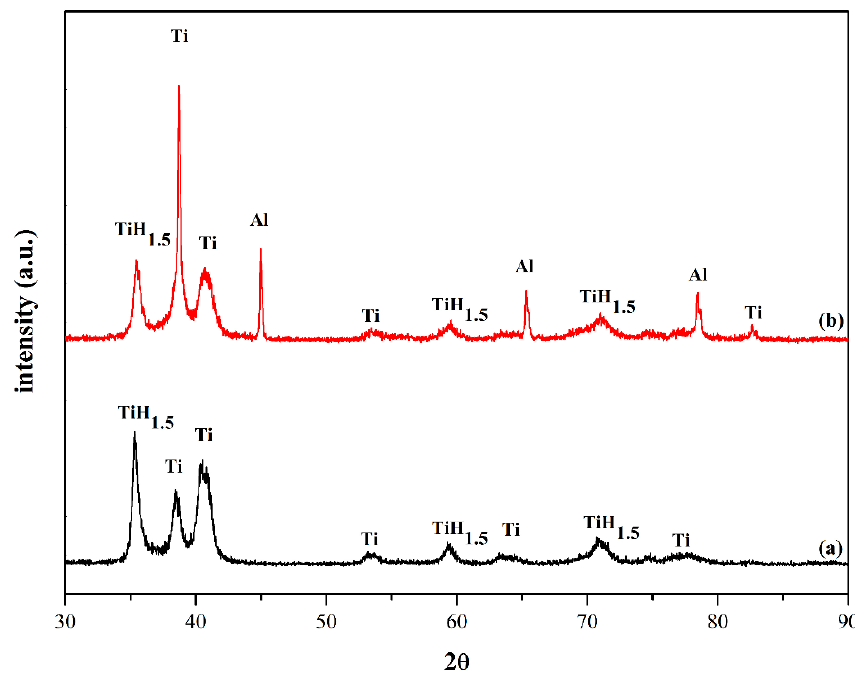
Figure 8. X-ray diffraction patterns of the coatings deposited by using ( a ) He and ( b ) air as the process gas.